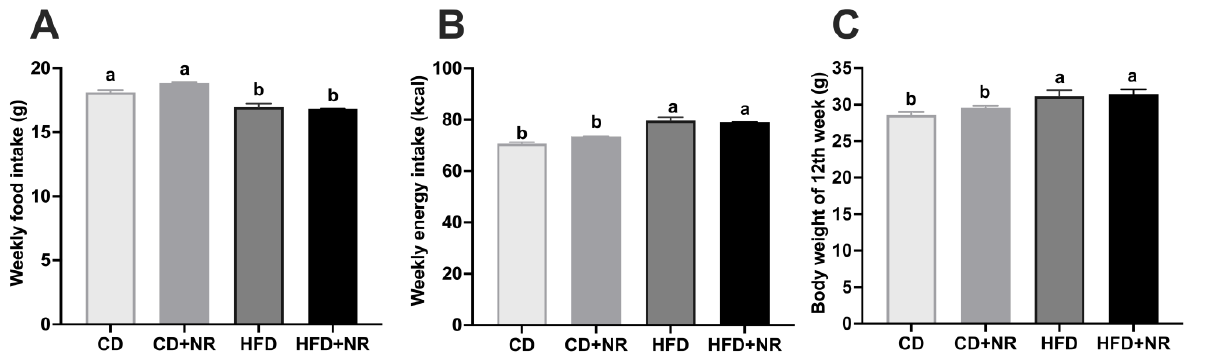
Figure 1. Weekly food and energy intakes and final body weights in ApoE −/− mice fed with a CD or HFD, without or with NR at the end of the study. ( A ) Weekly food intake; ( B ) Weekly energy intake; ( C ) Final body weight at the end of the study. Data were presented as mean ± SEM. A statistical analysis was performed using a two-way analysis of variance (ANOVA) or a Scheirer-Ray-Hare test with the main effects of diet and NR and diet*NR interaction, depending on whether the data were under normal distribution. Means with different letters (a or b) indicated a significant difference from each other. CD (control), n = 10; CD + NR, n = 11; HFD, n = 10; HFD + NR, n = 10. CD, control diet;